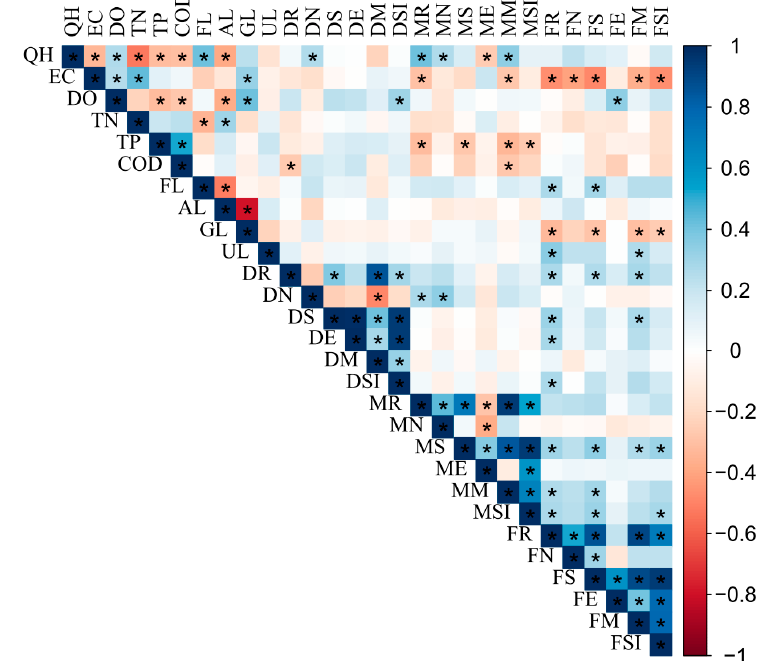
Figure 8. Correlation matrix between environmental variables and biotic indicators in the Wei River basin (* p < 0.05). D: diatom, M: macroinvertebrate, F: fish, R: richness, N: abundance, S: Shannon diversity, E: evenness, M: Margalef diversity, and SI: Simpson diversity.